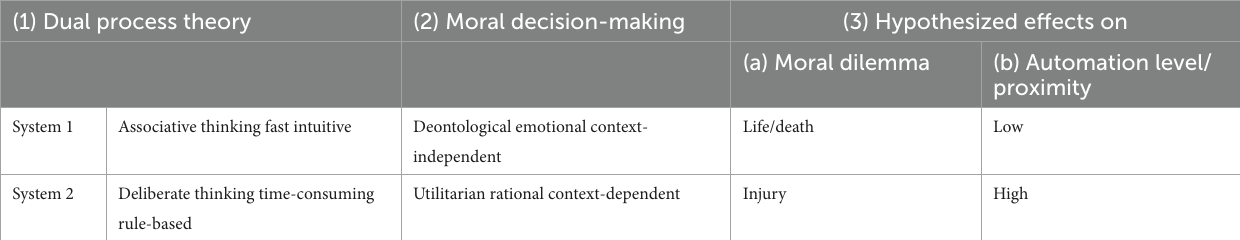
TABLE 1 Relationship of (1) dual-process-theory and (3) moral decision-making and (3) hypothesized effects on (A) moral dilemma decisions and (B) associated automation level/proximity in human-robot-collaboration. (1) Dual process